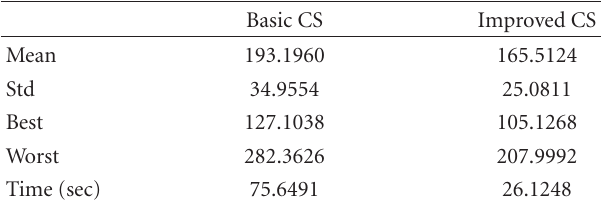
Table 1: Shortest length comparison between the basic CS and the improved CS in UCAV three-dimension path planning problem. The numbers shown are the results found after 100 Monte Carlo simulations of each